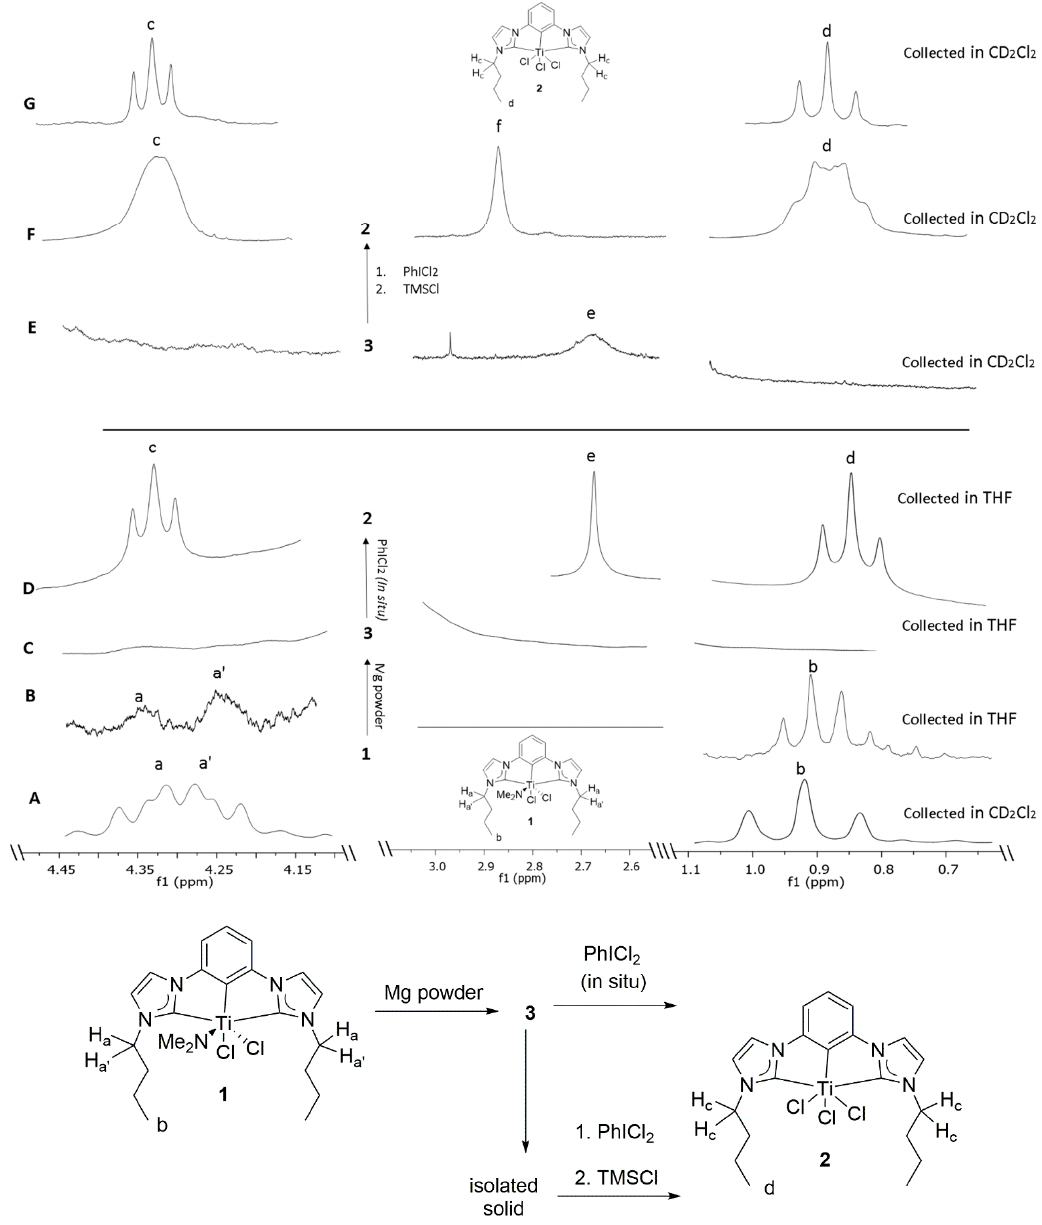
Figure 3. Stacked plot of characteristic peaks from the 1 H NMR spectra for the reduction with Mg powder followed by reoxidation. ( A ) Characteristic overlapping diastereotopic peaks (H a , H a’ ) and the triplet (H b ) of ((CCC-NHC)Ti(IV)Cl 2 (NMe 2 )) 1 in CD 2 Cl 2 for reference. ( B ) Characteristic overlapping diastereotopic peaks (H a , H a’ ) and the triplet (H b ) of (CCC-NHC)Ti(IV)Cl 2 NMe 2 ) 1 in no-D THF. ( C ) Characteristic regions in the 1 H NMR spectrum of intermediate 3 in no-D THF. ( D ) Characteristic triplet peaks (H c and H d ) identified as 2 in the 1 H NMR spectrum resulting from in situ oxidation of 3 with PhICl 2 in no-D THF [46]. ( E ) Characteristic regions of reduced species 3 in CD 2 Cl 2 . ( F ) Characteristic regions (H c and H d ) of 1 H NMR spectrum in CD 2 Cl 2 after reoxidation. ( G ) Characteristic triplets (H c and H d ) of ((CCC-NHC)Ti(IV)Cl 3 ) 2 in CD 2 Cl 2 for